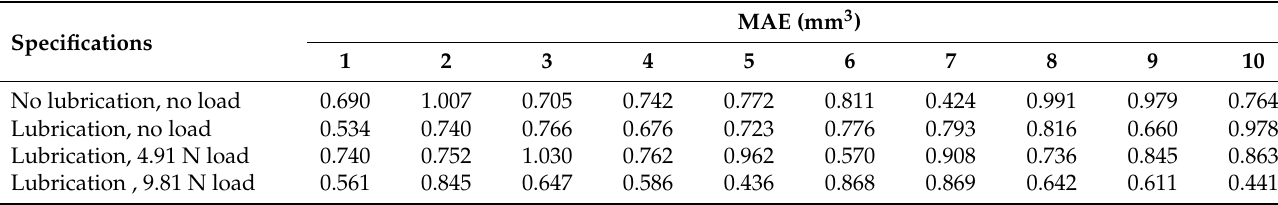
Table 5. Breakdown of metrics across validation sets.